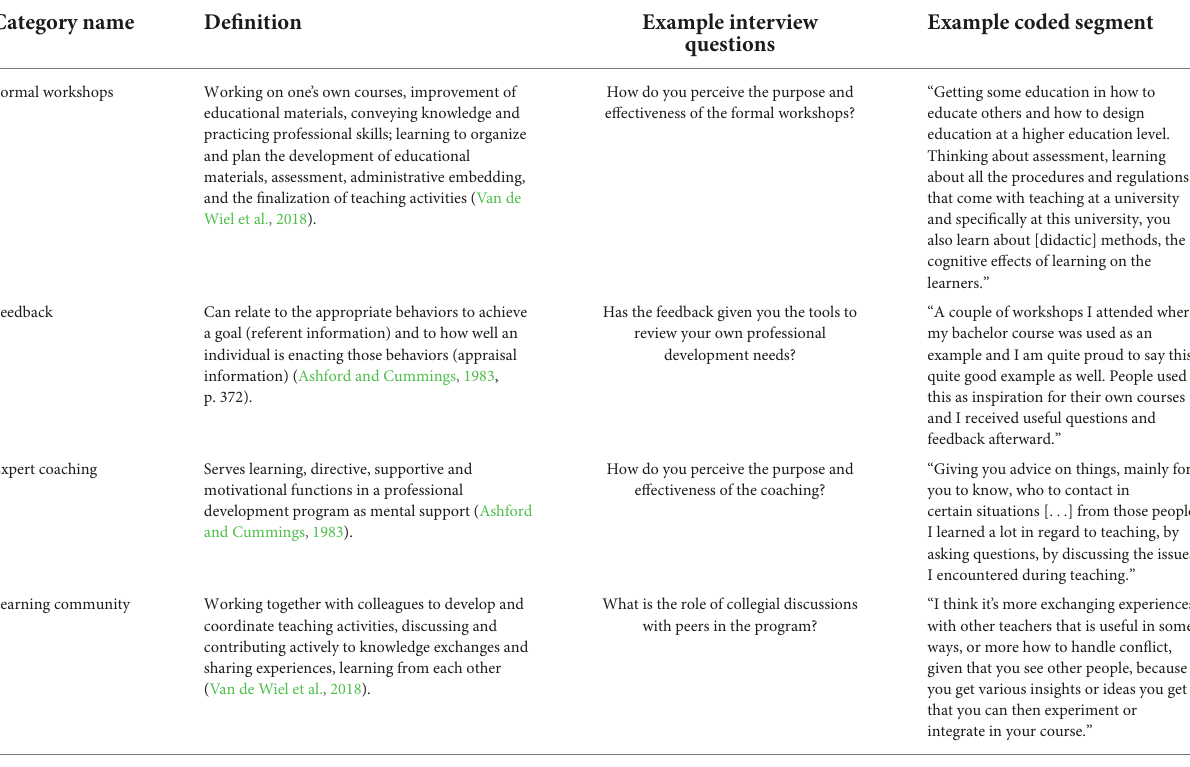
TABLE 2 Coding scheme and example interview questions and coded